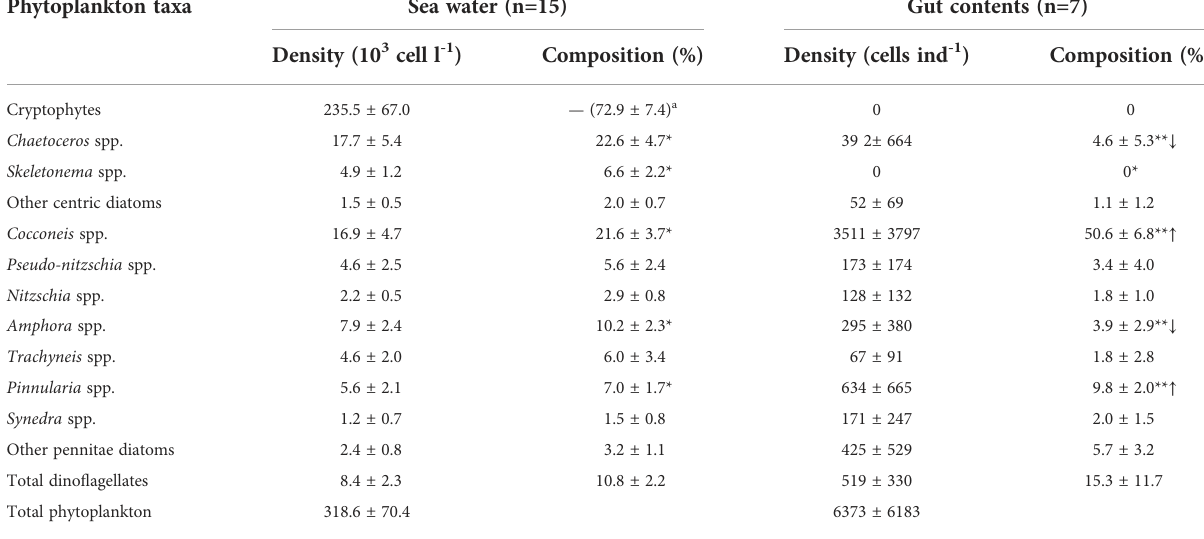
TABLE 2 Average density and composition of phytoplankton assemblages in sea water and gut contents (in accordance with gut contents, phytoplankton composition in seawater was only calculated for total diatoms and dino fl agellates but cryptophytes). Phytoplankton taxa